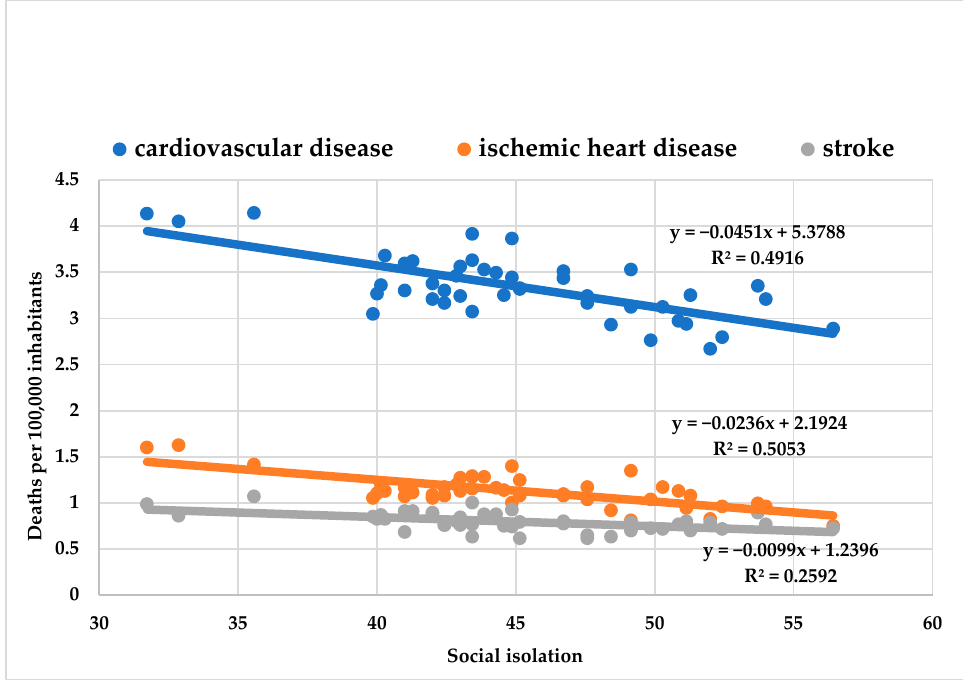
Figure 2. Correlation between weekly social isolation and deaths per 100,000 inhabitants from cardiovascular disease, ischemic heart disease, and stroke.